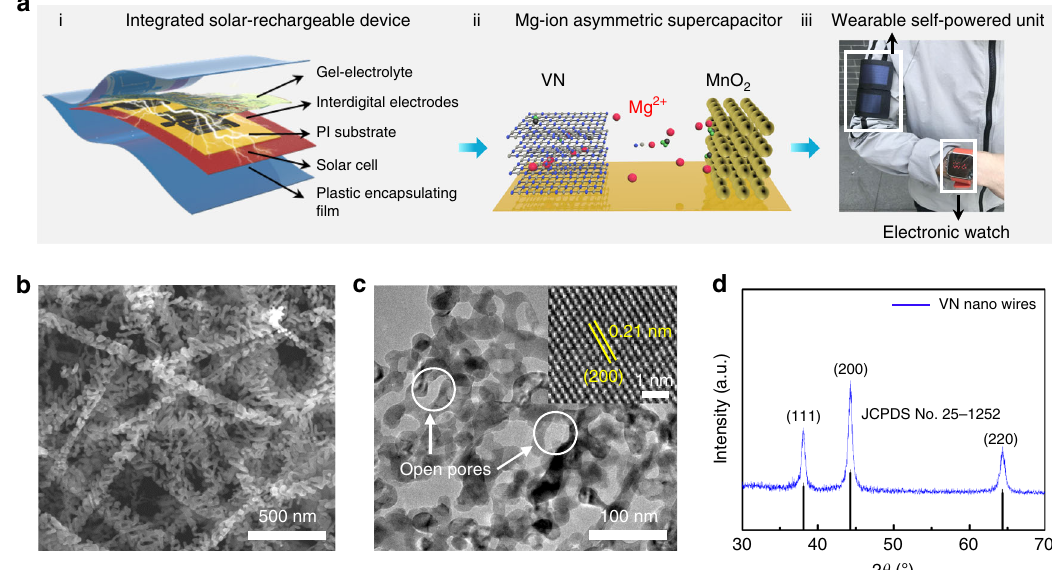
Fig. 1 Schematic illustration of the solar-charging integrated unit and characterization of VN nanowires. a Con fi guration of the solar-charging self-powered unit and proof-of-concept demonstration of wearable applications. b SEM image of as-prepared porous VN nanowires. c TEM image of VN nanowires. Inset: High-resolution STEM image. d XRD pattern of